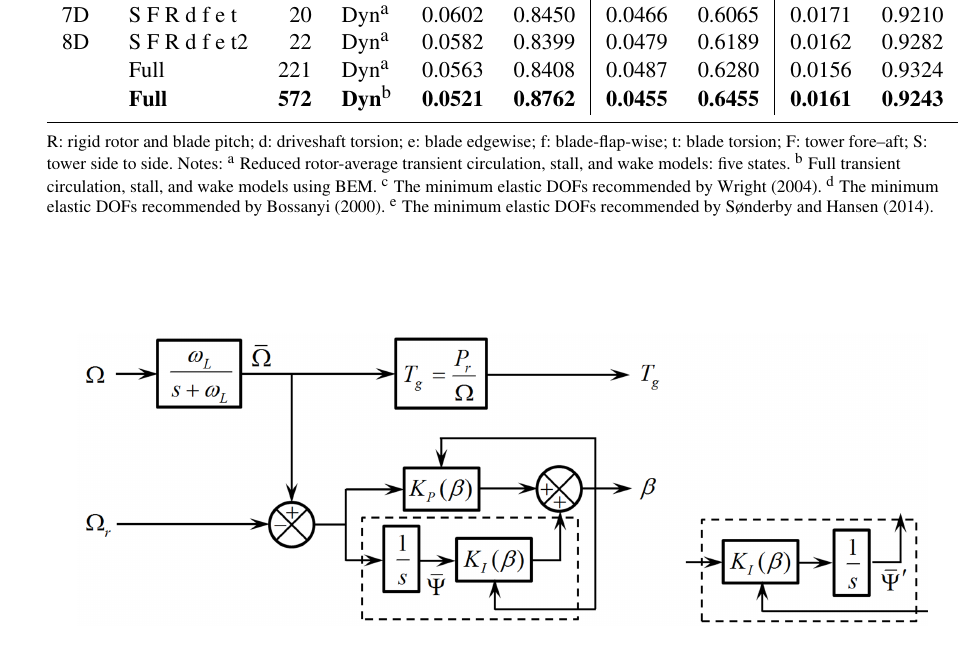
Figure 8. On the left, the equivalent functions of the NREL 5 MW turbine controller during normal, non-saturated operation. The integral pathway (dashed box) contains the scheduled gain outside the integrated speed error. On the right, an alternate integral pathway with the scheduled gain inside the integral of the speed